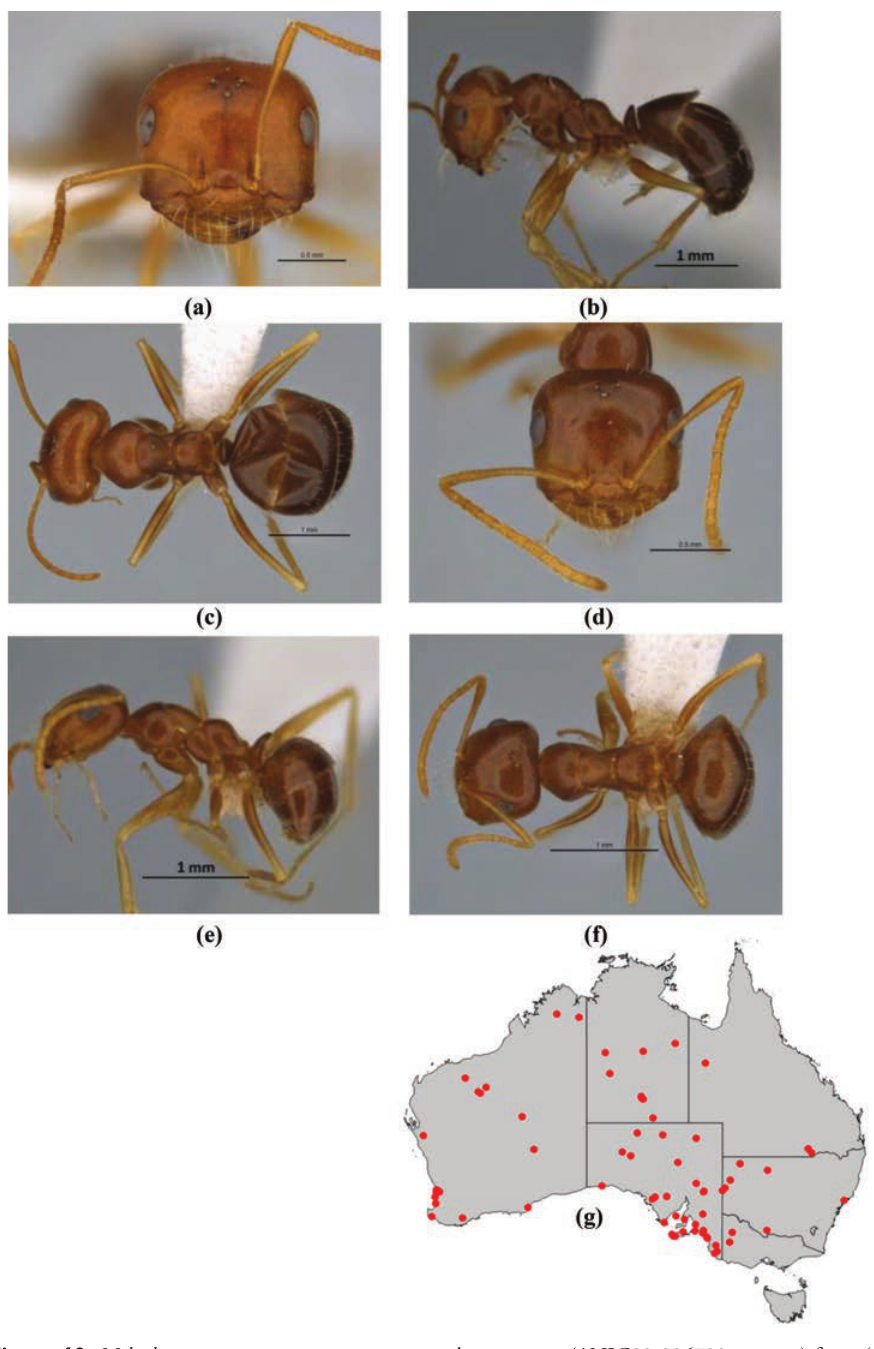
Figure 60. Melophorus inconspicuus sp. n.: major worker paratype (ANIC32-006700–top ant) frons ( a ), profile ( b ) and dorsum ( c ); minor worker holotype (ANIC32-006700–bottom ant) frons ( d ), profile ( e ) and dorsum ( f ); distribution map for the species ( g ). Low resolution scale bars: 1 mm ( c, f ); 0.5 mm ( a, d